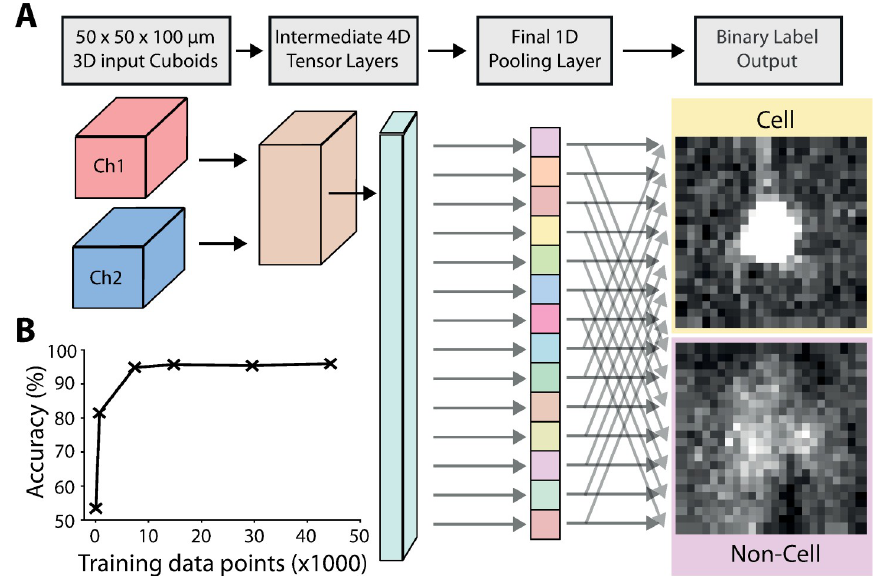
Fig 3. Cell classification. A: The input data to the modified ResNet are 3D image cuboids (50 μ m x 50 μ m x 100 μ m) centered on each cell candidate. There are two cuboids, one from the primary signal channel, and one from the secondary autofluorescence channel. The data is then fed through the network, resulting in a binary label of cell or non-cell. During training the network “learns” to distinguish true cells, from other bright non-cellular objects. See S3 and S4 Figs for more details of the 3D ResNet architecture. B: Training the initial cell classification network: classification accuracy as a function of training data quantity.